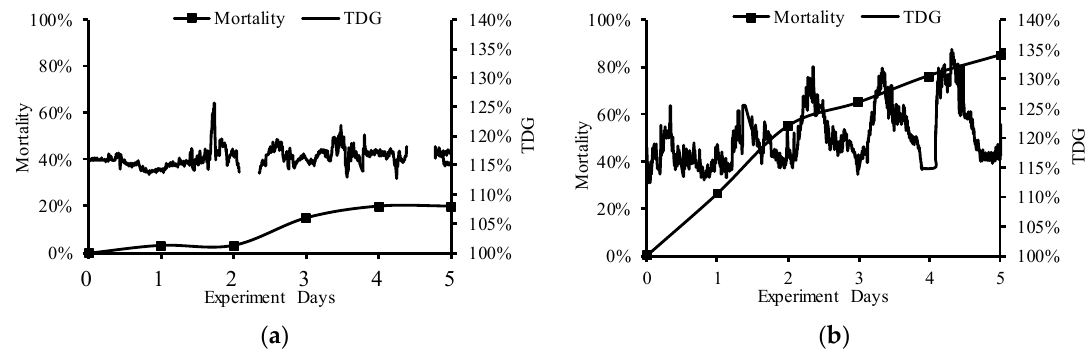
Figure 5. Mortality at the experimental site during the two field experiments, ( a , b ) represent the